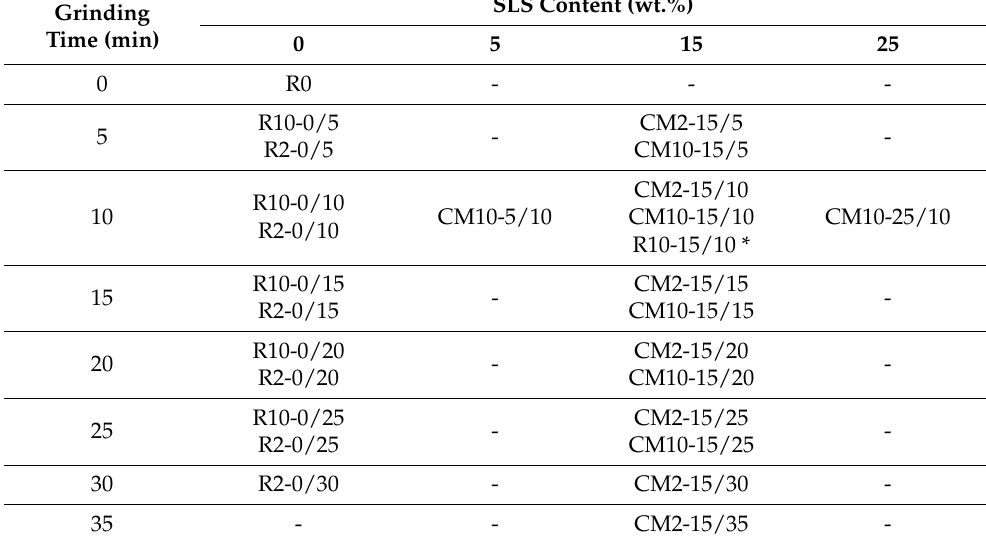
Table 1. Overview of prepared MLX mixtures with SLS. R—reference, CM—co-milled samples.